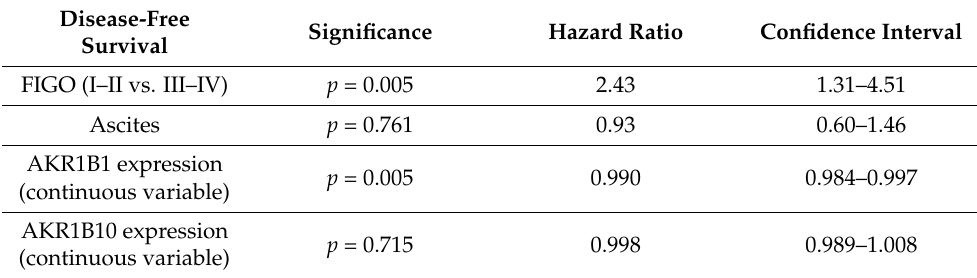
Table 4. Multivariate Cox analysis of independent prognostic factors of disease-free